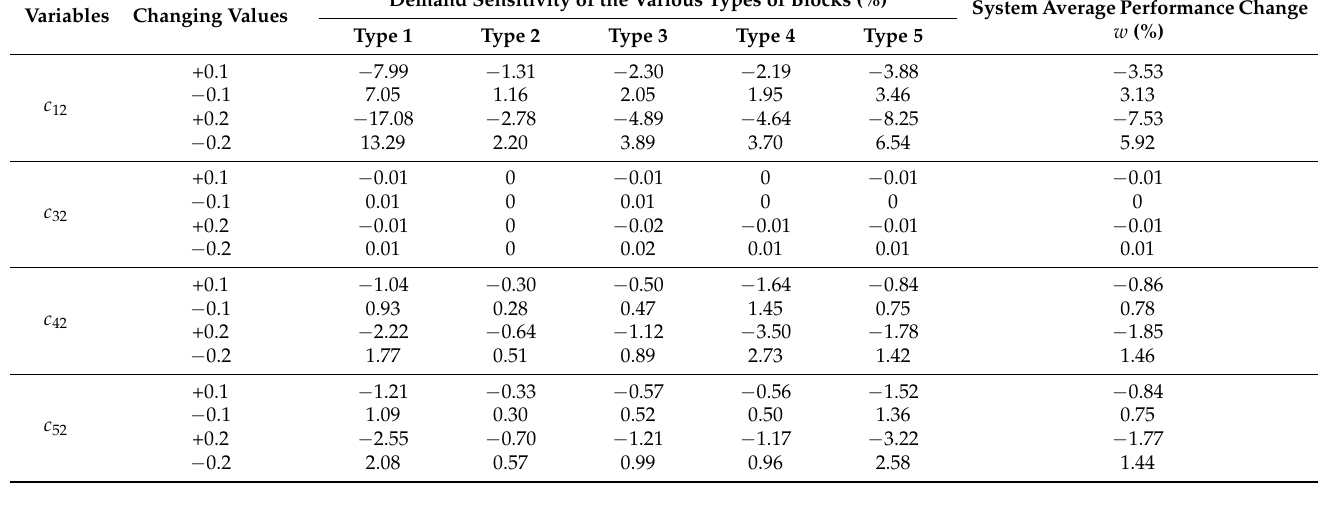
Table 4. Sensitivity analysis table.